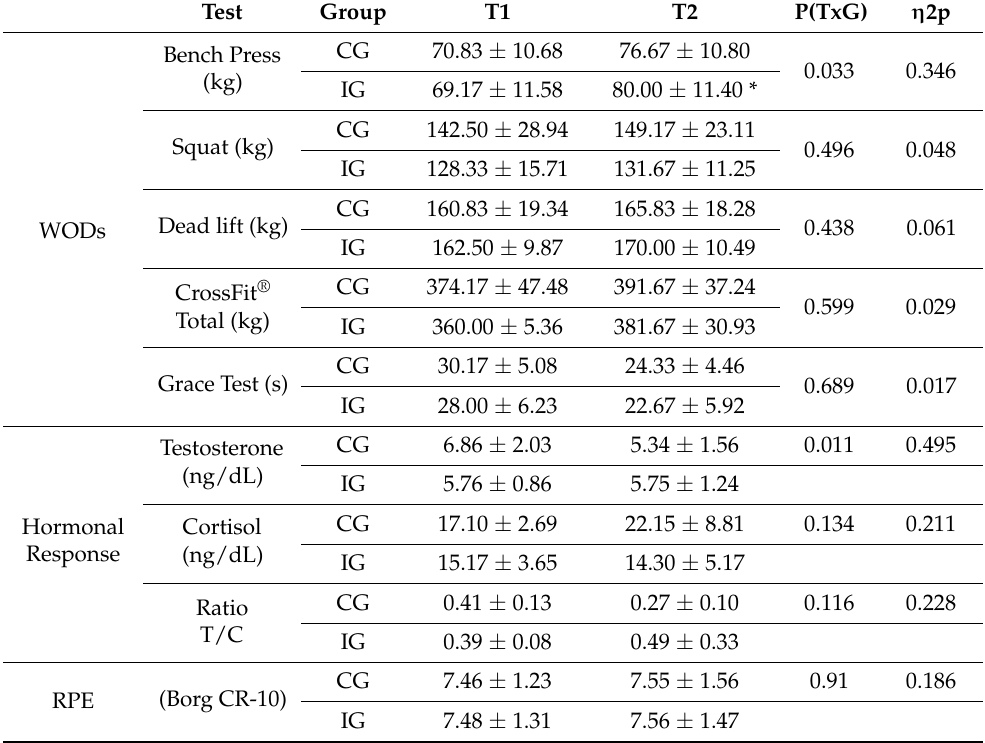
Table 4. Results of the Workouts of the Day (WODs), hormonal response, and rate perceived at baseline (T1) and after 6 weeks